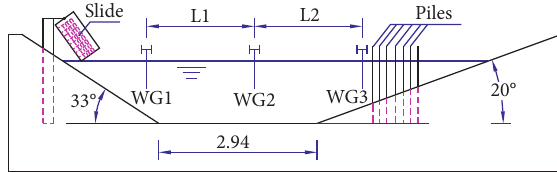
Figure 2: The detailed setup of three wave gauges.